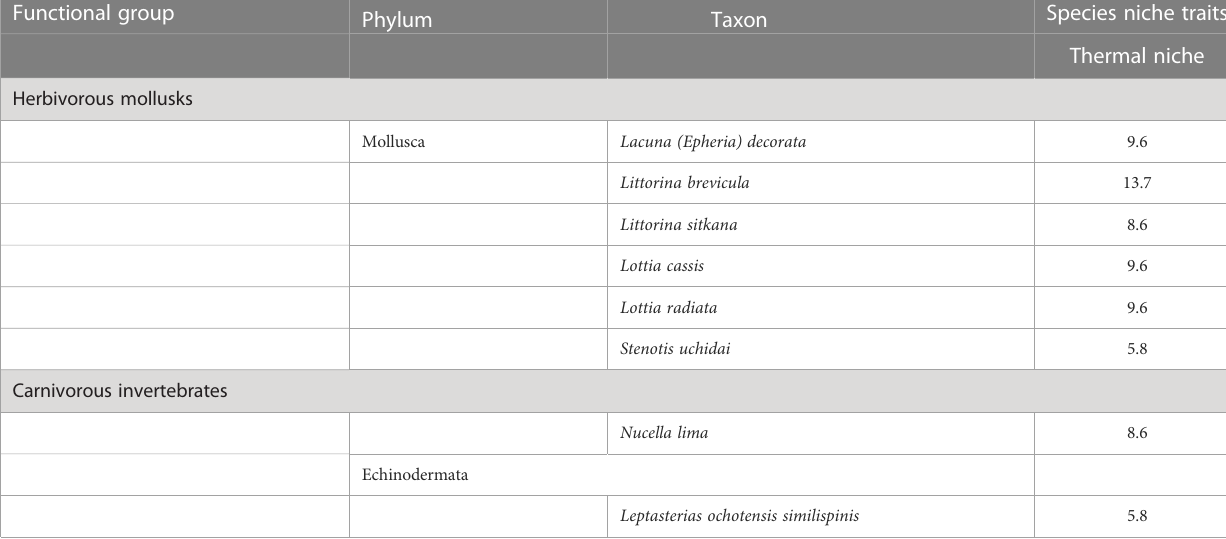
TABLE 9 Species niche trait of eight mobile